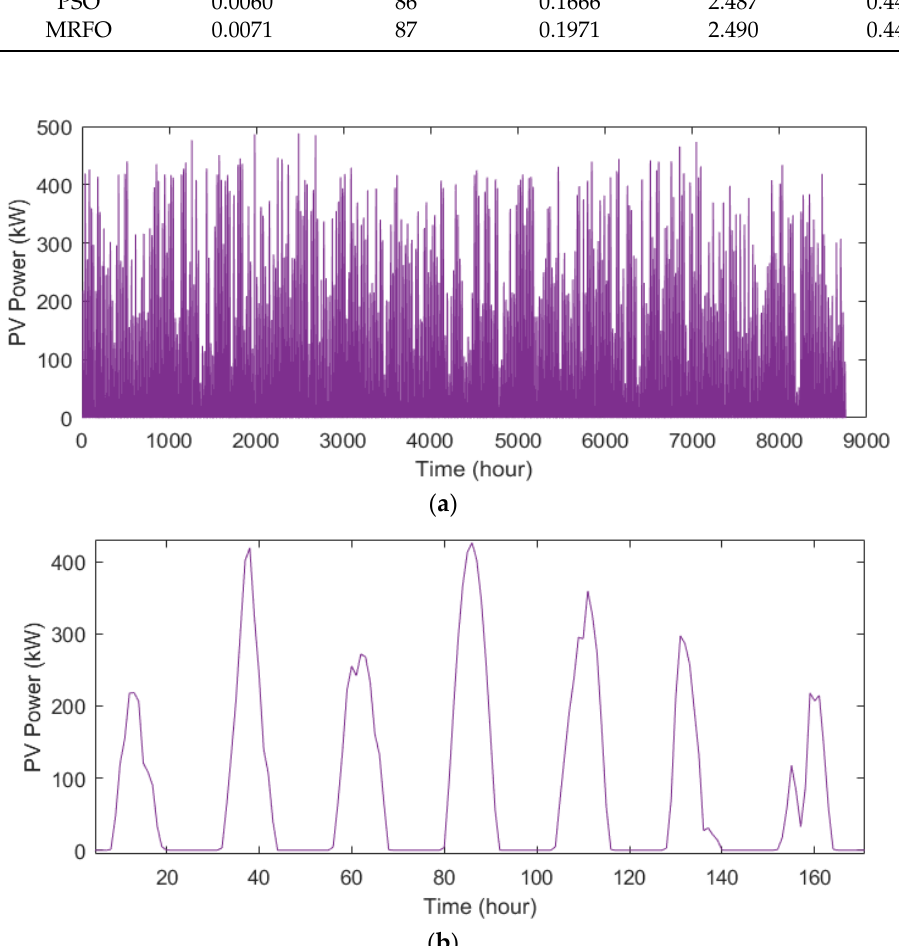
Figure 7. Generated power from PV resources considered in the sizing of the HPV/FC energy system via the IAEO, considering ENSP max = 1% during ( a ) a year and ( b ) a week.